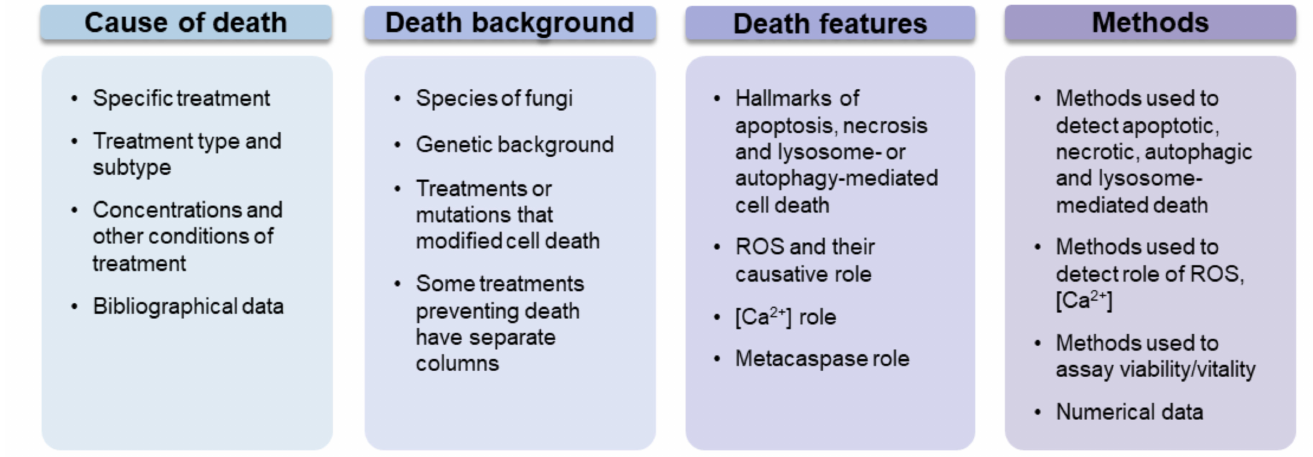
Figure 1. Overview of data associated with each cell death stimulus from each paper as compiled in Table